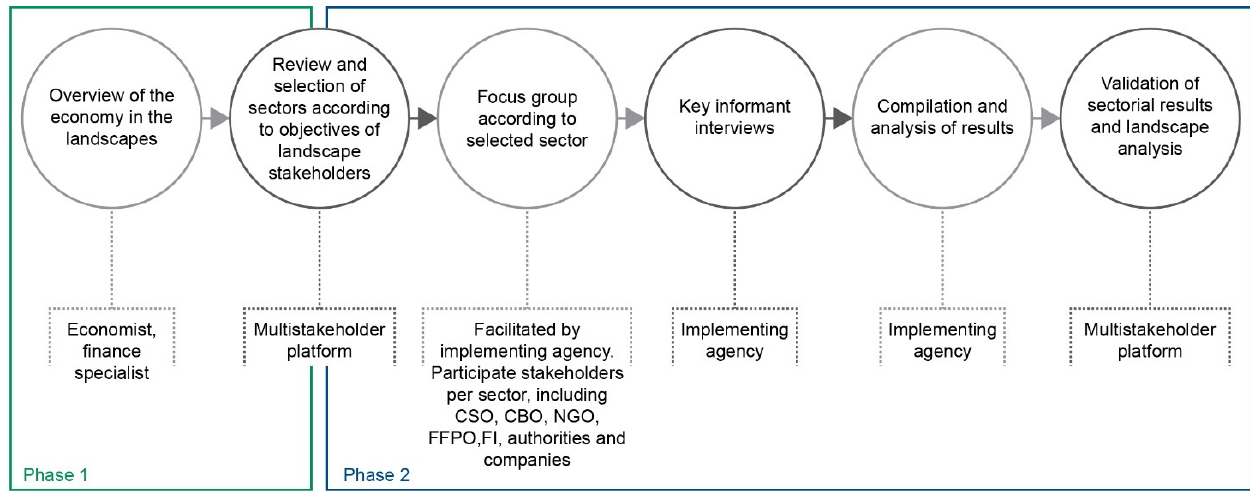
Figure 1. The general flow of the assessment process. CSO: civic society organizations; CBO: community-based organiza- tions; NGO: non-government organizations; FFPO: forest and farm producer organizations; FI: financial institutions.